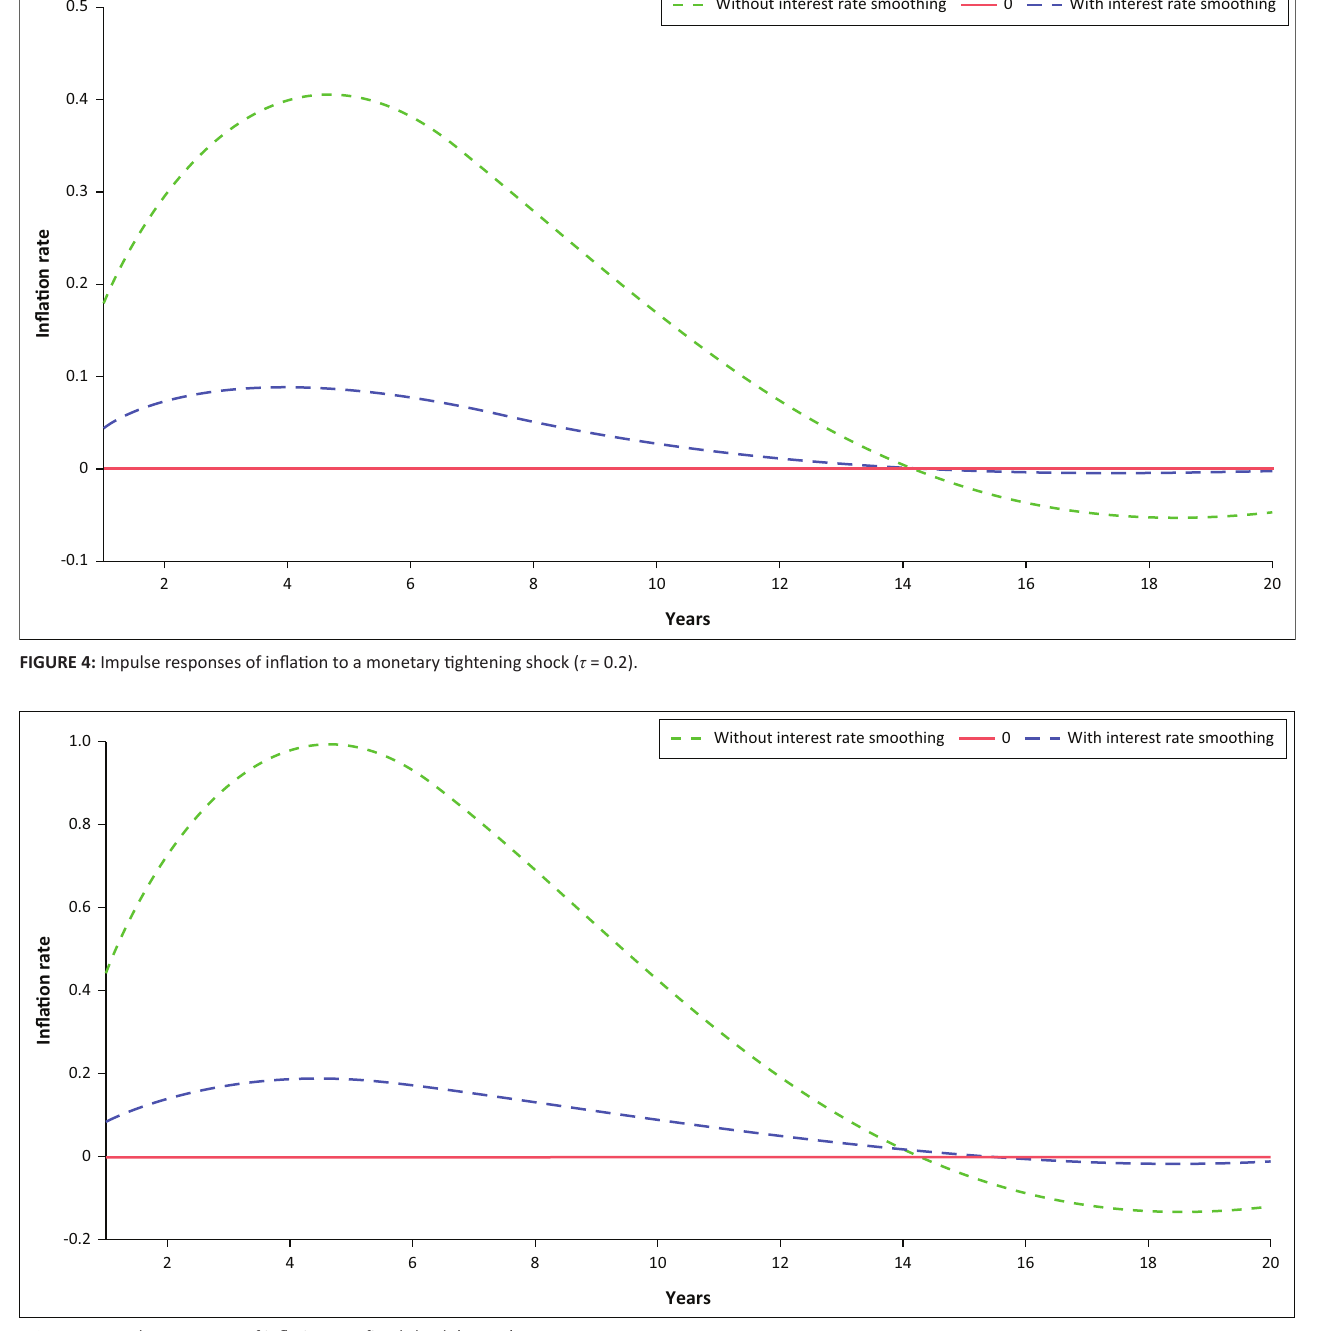
FIG URE 5: Impulse responses of inflation to a fiscal shock ( τ =